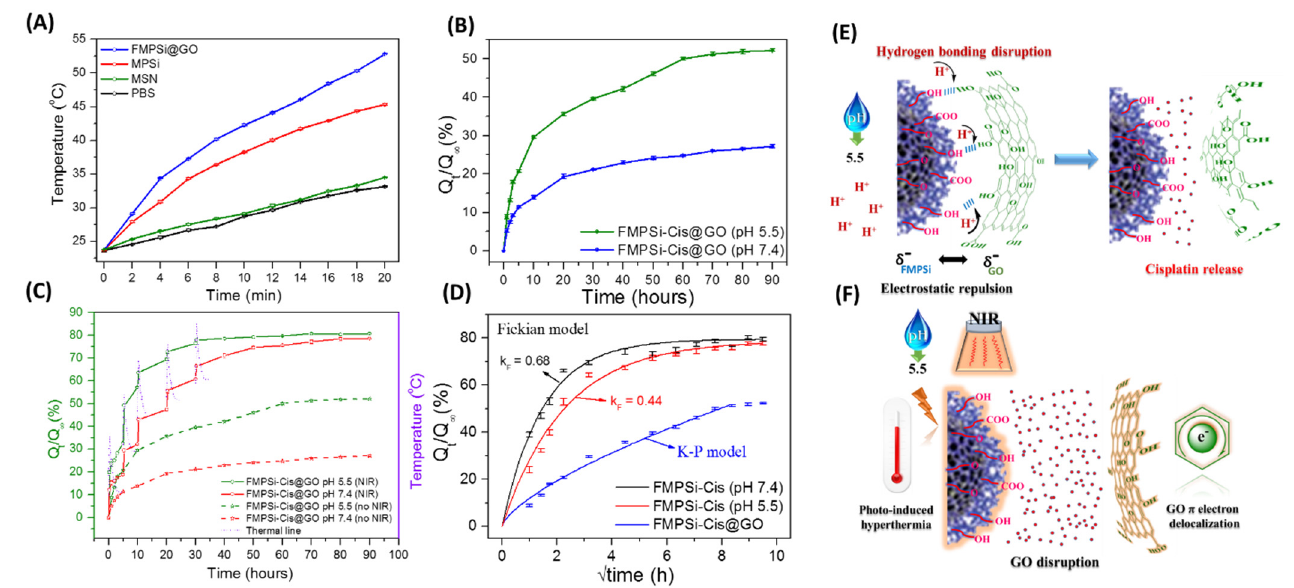
Figure 2. ( A ) Temperature changes of pure PBS, MSN, MPSi, and FMPSi@GO solutions during NIR light exposure (808 nm) at a power density of 1.0 W/cm 2 for 20 min; ( B ) Cis release profiles of FMPSi-Cis@GO in PBS at pH 7.4 and pH 5.5; ( C ) Cumulative release fractions of FMPSi-Cis@GO in PBS at pH 5.5 and pH 7.4 before and after NIR irradiation (808 nm laser, 1.0 W/cm 2 ) for 20 min. The dotted lines of purple color indicate the temperature changes of in vitro solution by the periodic irradiations of NIR light for 20 min; ( D ) Model fits of release profiles of FMPSi-Cis at pH 5.5 and pH 7.4 and release profiles of FMPSi-Cis@GO in PBS (pH 5.5) at 37 °C; and Schematic representation of stimuli-responsive controlled drug release from FMPSi-Cis@GO; ( E ) pH effects on drug release mechanism of FMPSi-based NPs; and ( F ) NIR irradiation effect on drug release mechanism of FMPSi-based NPs.